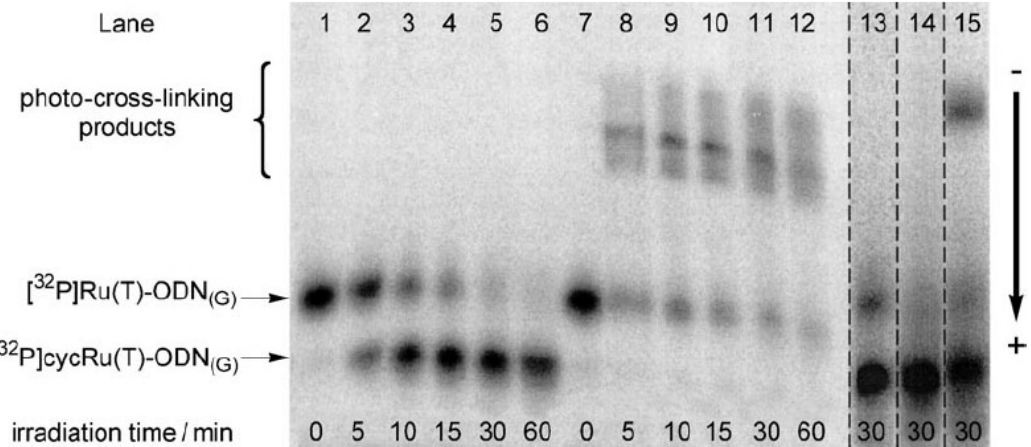
Figure 17. PAGE analysis of the photochemical behaviour of Ru(T) - ODN(G) in the absence (lanes 1–6) and in the presence (lanes 7–12) of the complementary target strand. Lanes 13, 14, and 15 correspond to Ru(T) - ODN(G) that was irradiated for 30 min in the presence of non-complementary sequences. Figure taken from [141] with permission.